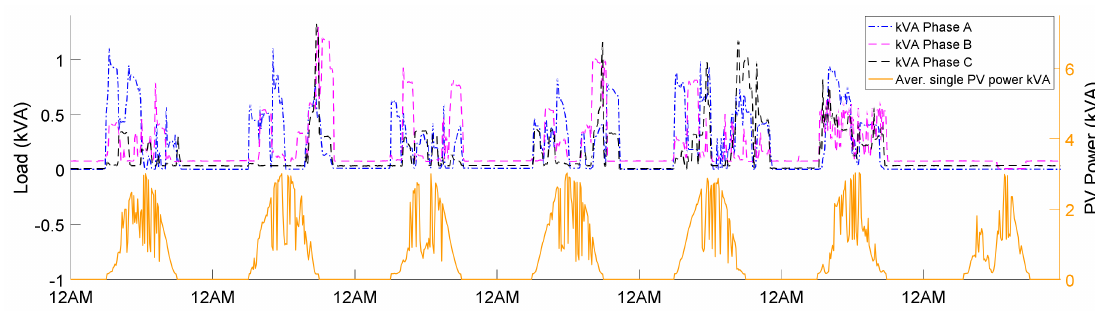
Figure 9. Apparent power demand during one week with PV injection.